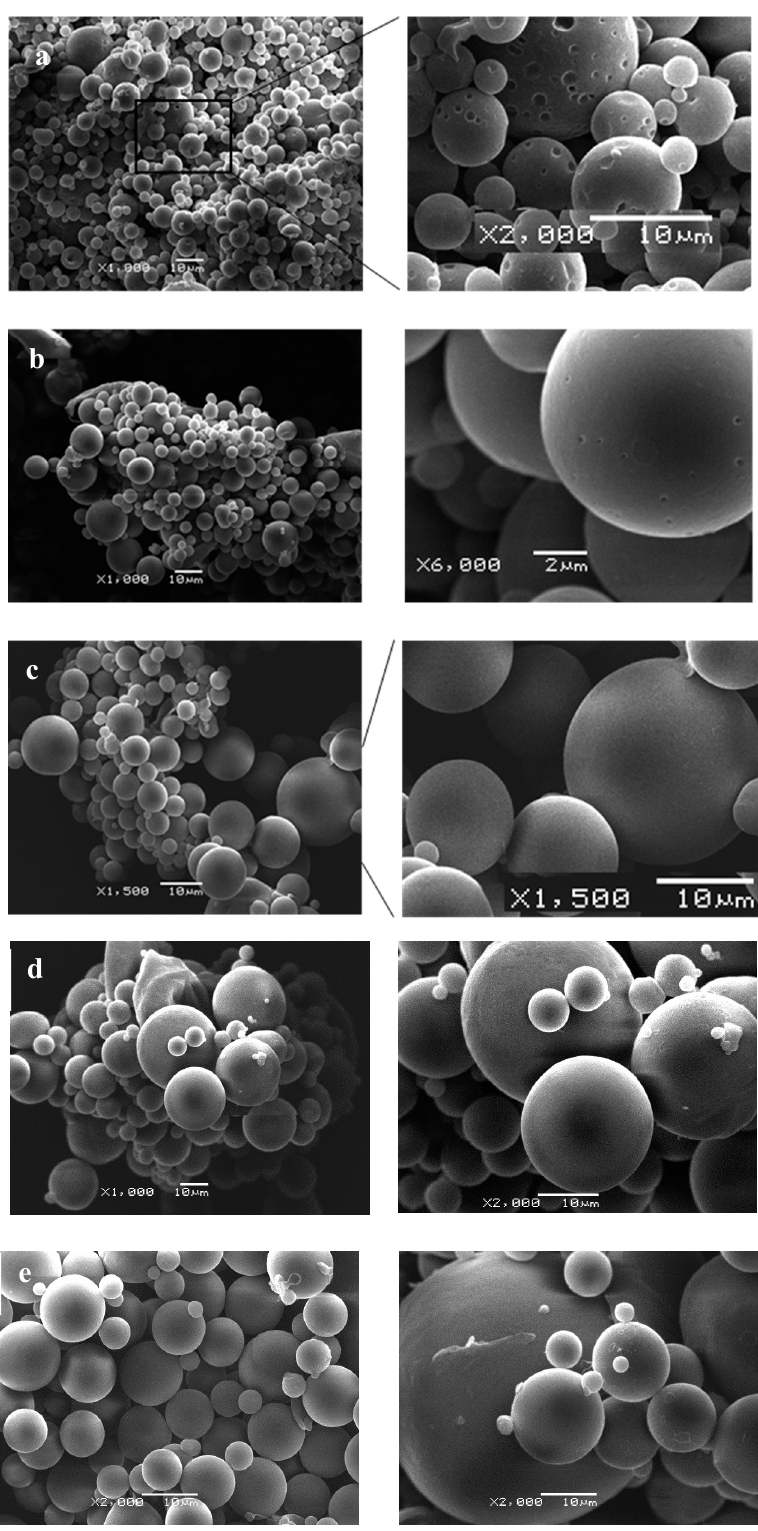
Figure 2. Representative Scanning electron microscopy (SEM) micrographs of RSV-loaded microcapsules: ( a ) F1 (0.08% PCL; 5 W); ( b ) F3 (0.5% PCL; 6 W); ( c ) F5 (1.5% PCL; 5 W); ( d ) F7 (2.5% PCL; 4 W); ( e ) F9 (2.91% PCL; 5 W).